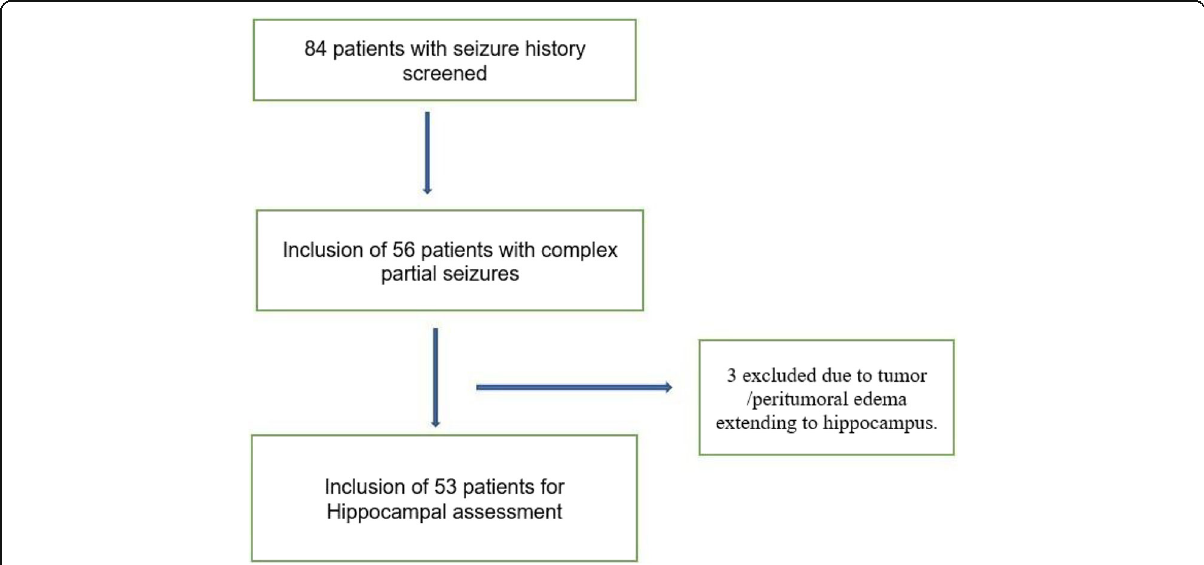
Fig. 1 Strobe diagram showing the methodology of the section of the cases for hippocampal assessment in patients presenting with focal onset seizure with impaired